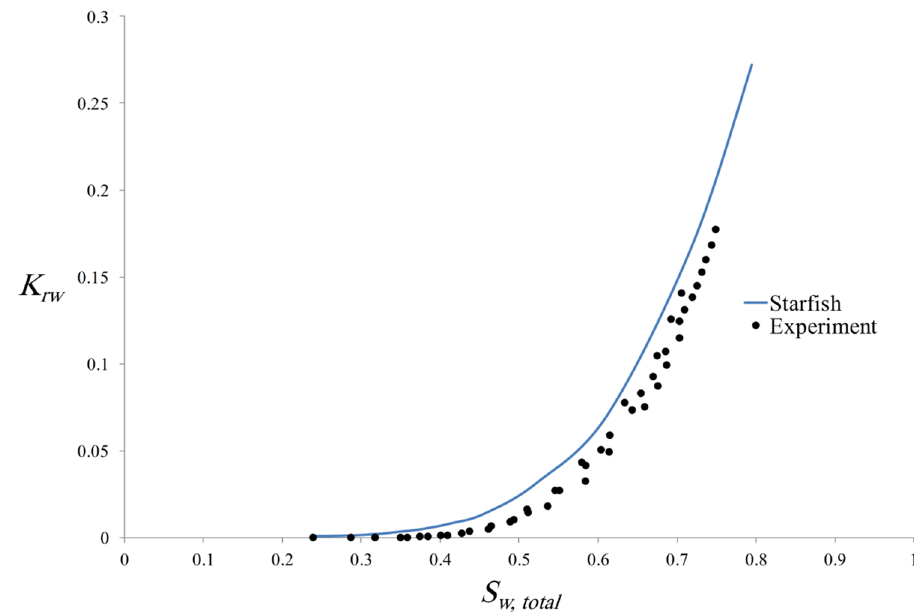
Fig. 4 Simulated and experi-